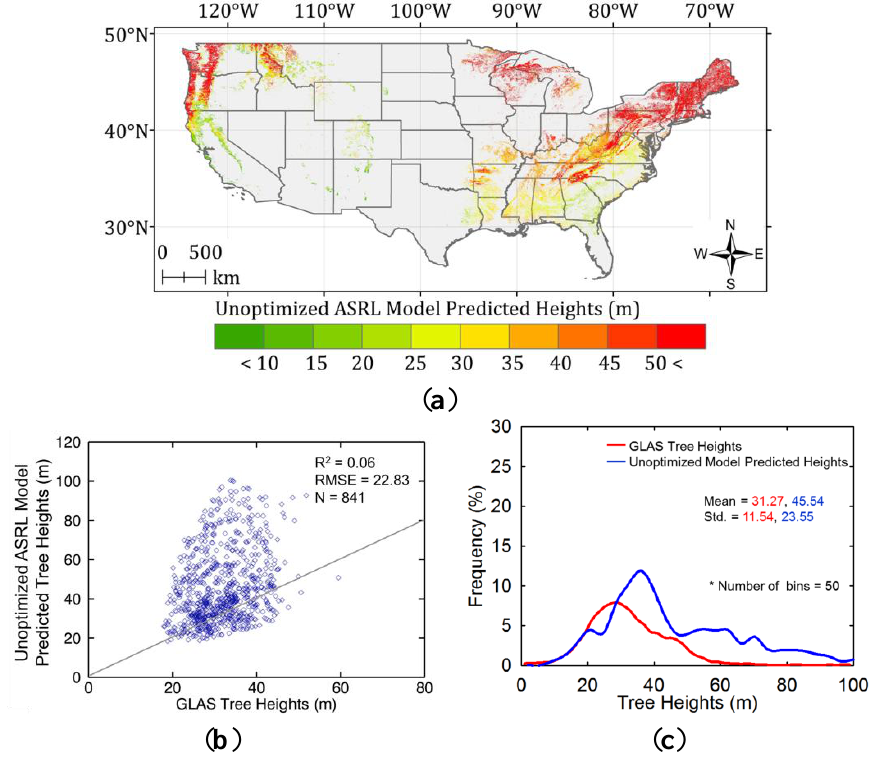
Figure 3. ( a ) Map of potential tree heights predicted by the unoptimized ASRL model for the CONUS at 1 km resolution. ( b ) Comparison between GLAS tree heights and unoptimized model predictions in each of the climatic zones. ( c ) Histograms showing pixel level comparison between GLAS and potential tree heights. Number of bins of histograms is 50. Frequencies have been normalized by total grids (frequency